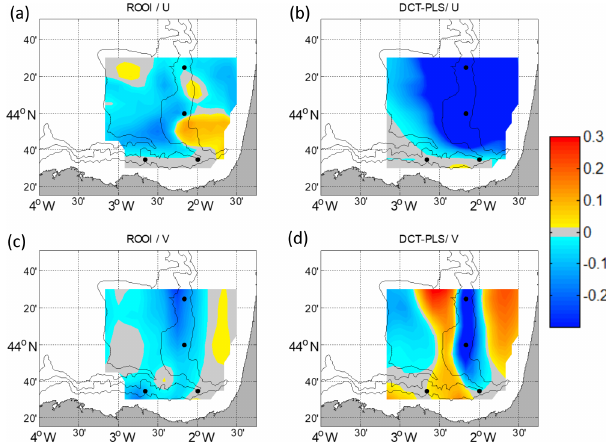
Figure 12. The 4-mooring scenario RRMSD maps subtracted by the 2-mooring scenario RRMSD maps for winter at − 52m. Negative values mean a better performance in the 4-mooring scenario for U (a, b) and for V (c, d) for the ROOI (a, c) and for the DCT-PLS (b, d) . The black dots depict the locations of current vertical